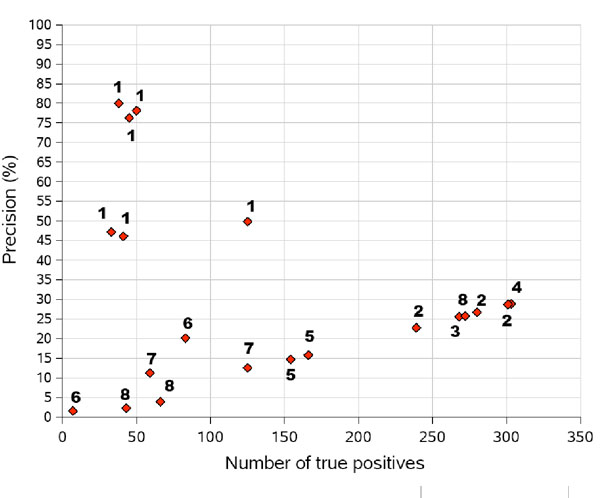
Task 2.1 Precision versus total true positives (TP) plot. Task 2.1 results: precision vs total number of true positives (protein and GO term predicted correctly, i.e. evaluated as 'high'). Each point represents a single run submitted by the participants of task 2.1. 1: Chiang et al., 2: Couto et al., 3: Ehrler et al., 4: Krallinger et al., 5: Krymolowski et al., 6:Ray et al., 7: Rice et al., 8: Verspoor et al.